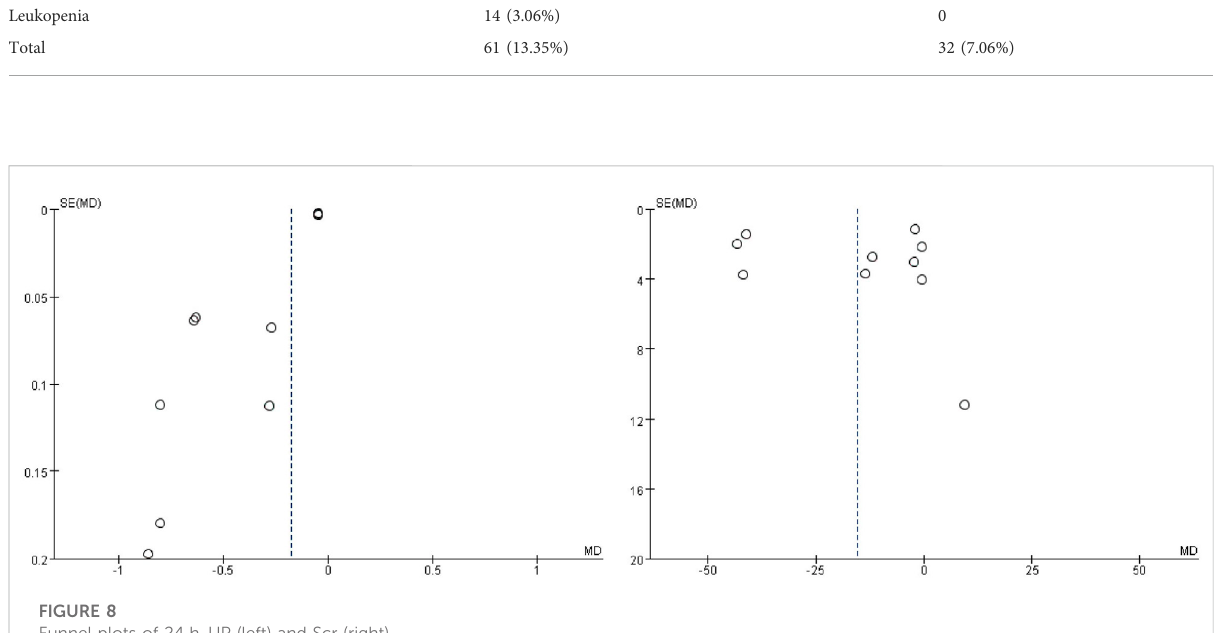
FIGURE 8 Funnel plots of 24 h-UP (left) and Scr